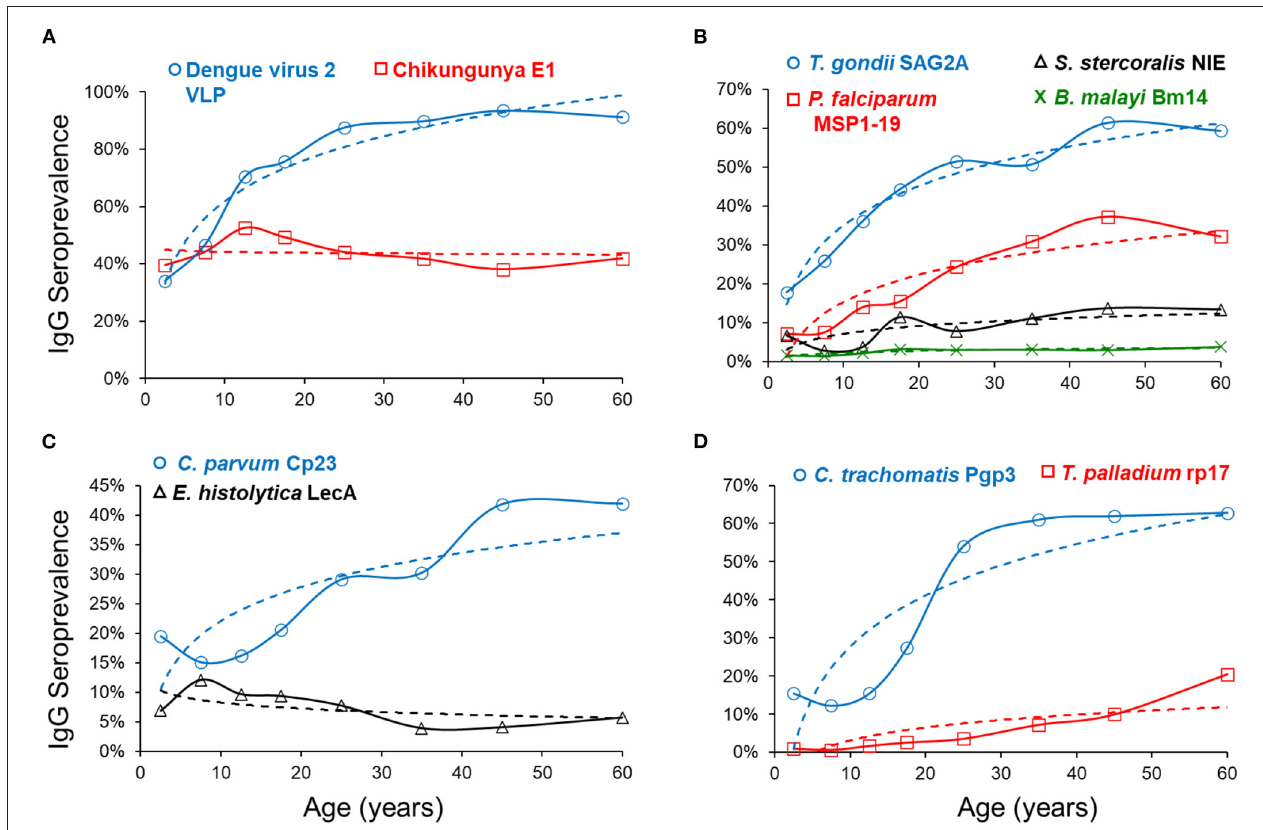
FIGURE 2 | Seroprevalence by Age and Regression Fitting for Selected Antigens. By age category, mean seroprevalence (as plotted by percent IgG positive) was plotted on y-axis and age on x-axis. Dashed regression lines were fitted to a logarithmic equation for positivity by age and grouped into similar categories of arboviruses (A) , non-waterborne parasites (B) , waterborne pathogens (C) , and other bacterial pathogens (D)